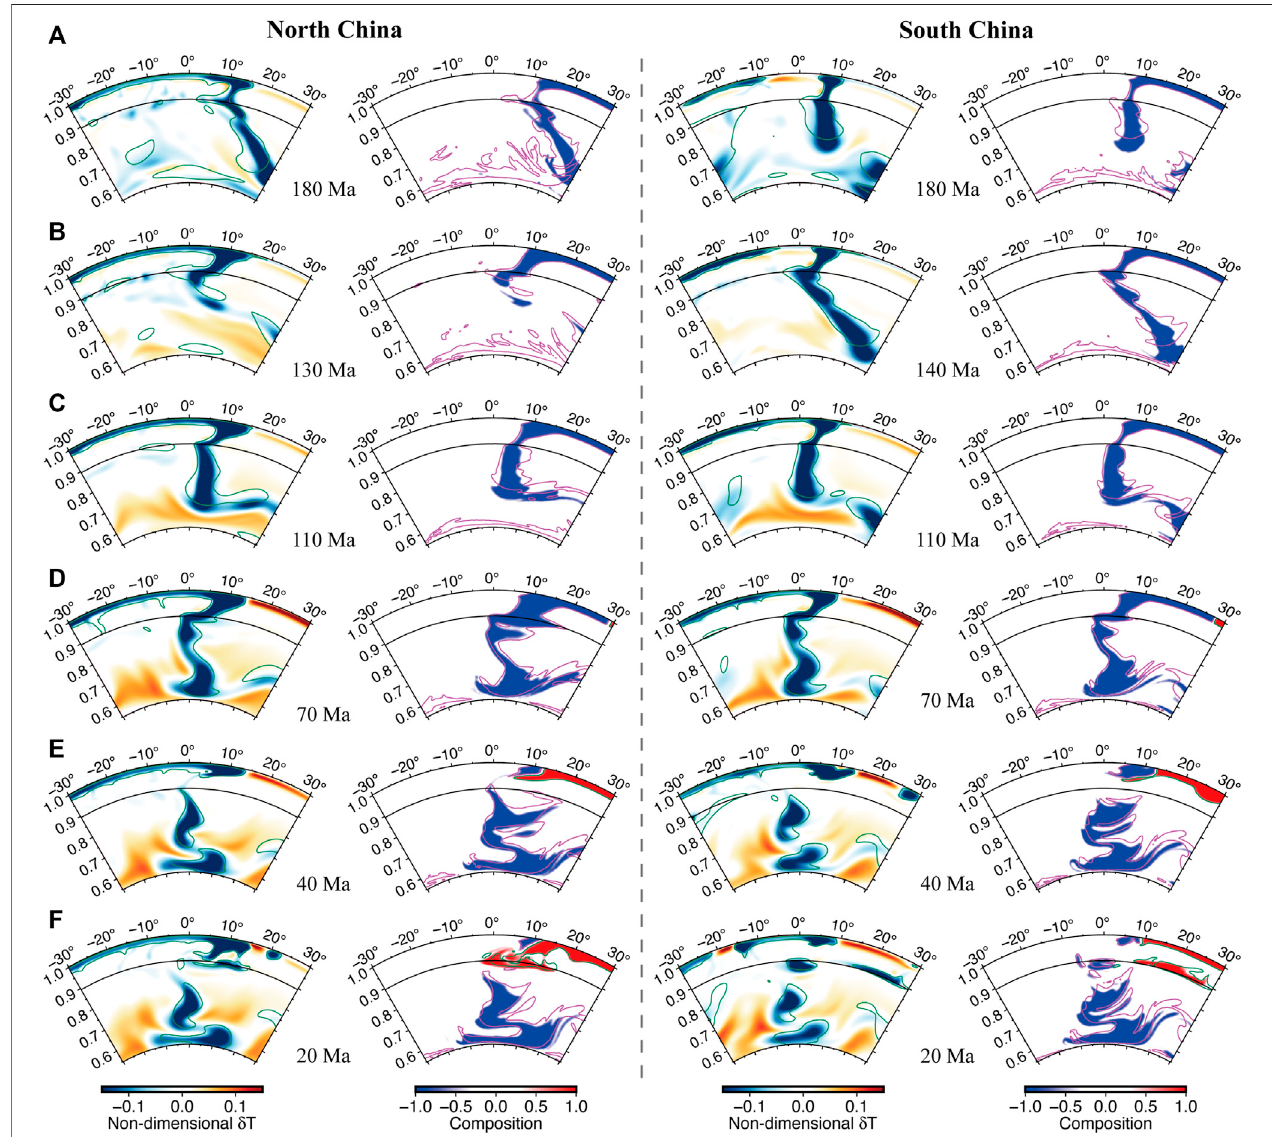
FIGURE 7 | Slab structures of the Izanagi-Paci fi c Plate beneath the North China Craton (left columns) and the South China Block (right columns) at some time snapshots for case 4. In (A – F) , the left and right columns are cross-sections of the residual temperature and composition fi elds across the NCC and the SCB, respectively. Line descriptions are the same as those in Figure 5